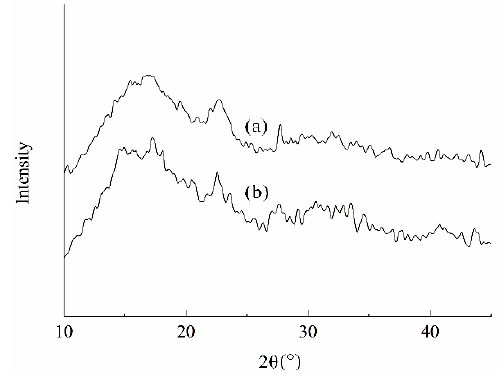
Figure 7. X-ray diffractograms of QHOTS film (a) and OTS one (b).